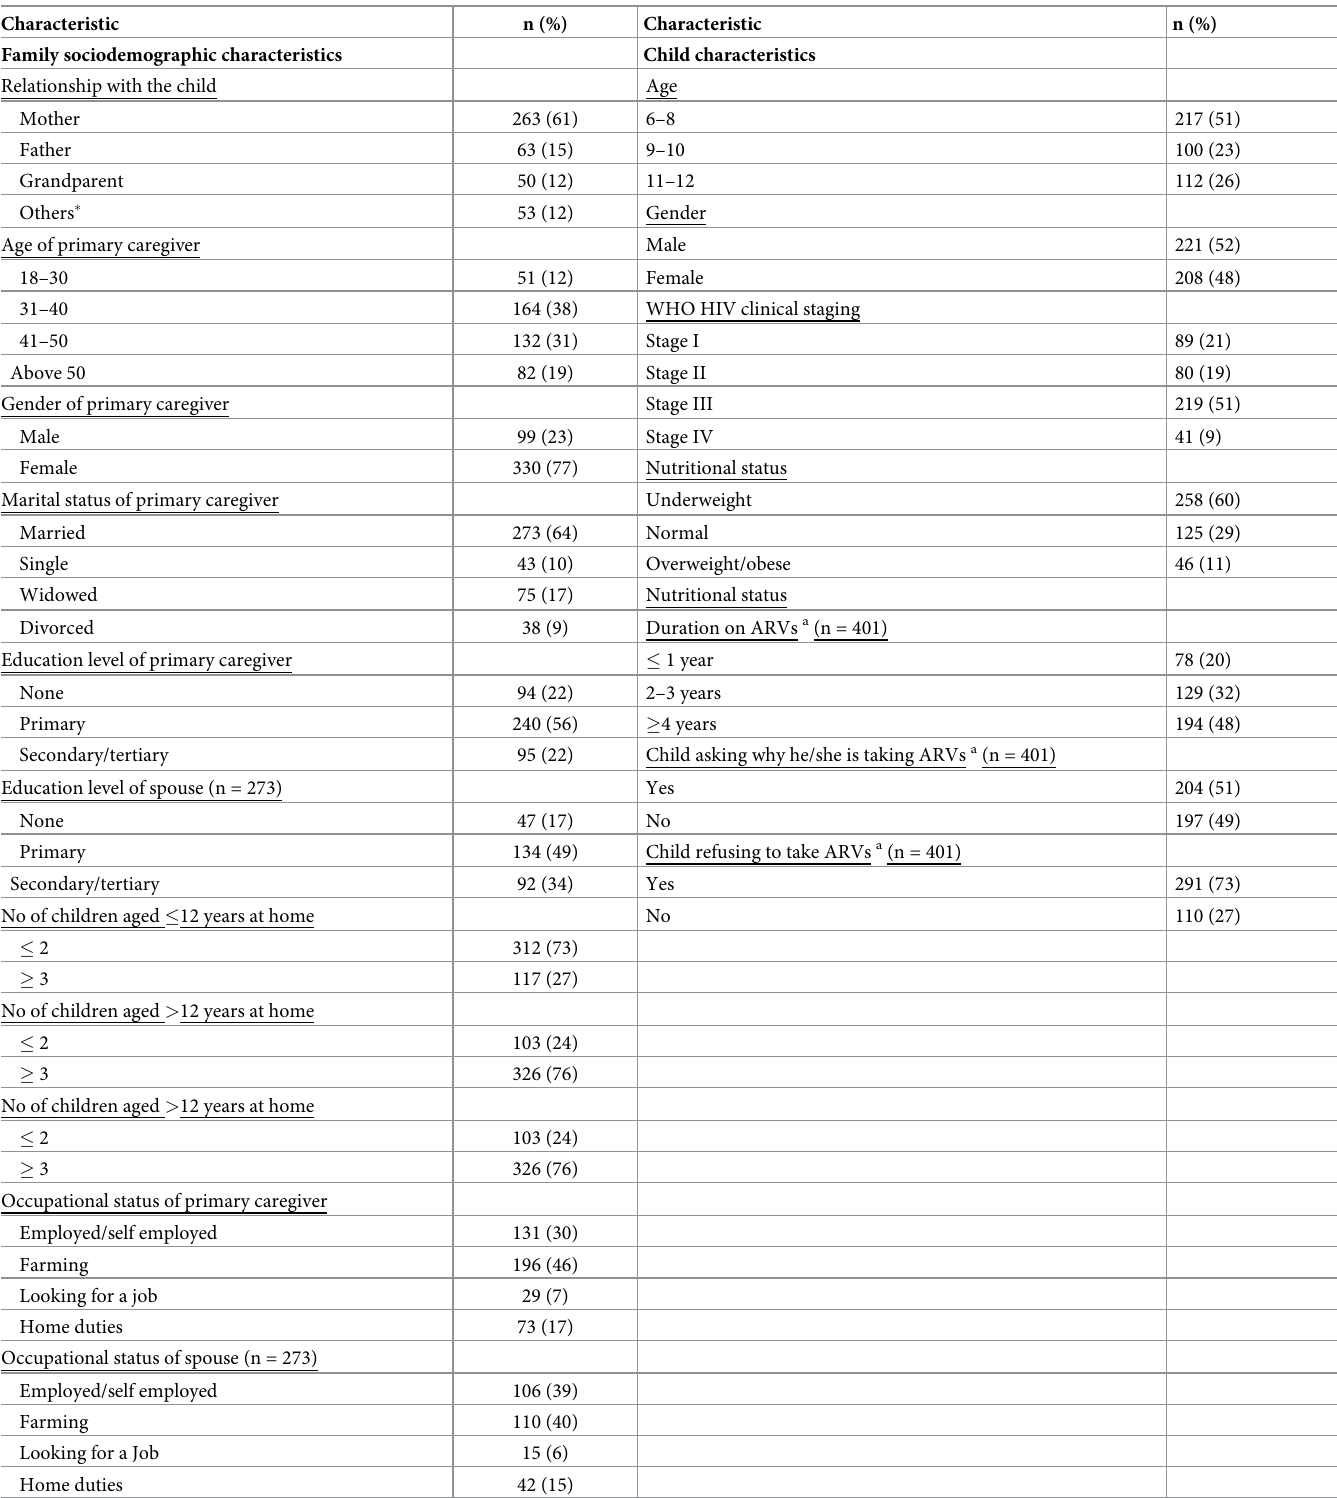
Table 1. Family sociodemographic and child characteristics (N =